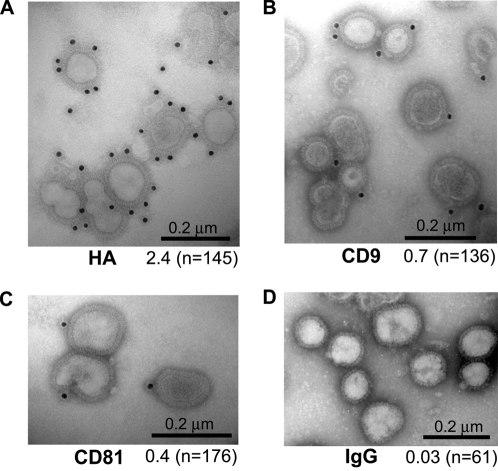
Immunogold labeling of host proteins in purified influenza virions.Influenza virions purified from the supernatant of infected Vero cells were immunogold labeled with antibodies against (A) Hemagglutinin, (B) CD9, (C) CD81 and (D) normal mouse IgG. Labeled virus was negatively stained with sodium silicotungstate and visualized by electron microscopy (50,000× magnification). The number of gold particles per virion is shown below (n = the number of virions counted).